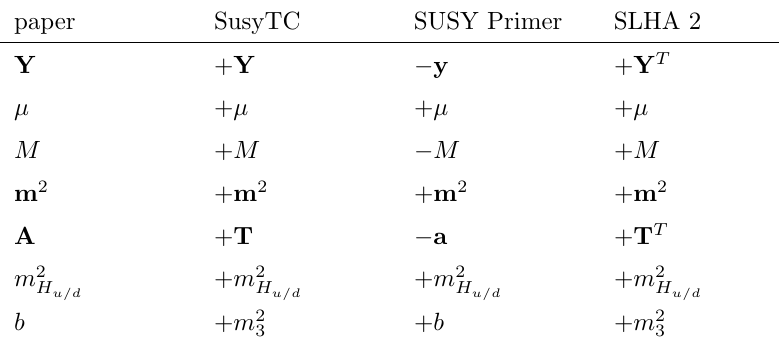
Table 1 . Comparison of the labels and conventions chosen in this paper for the quantities present in W MSSM in eq. (2.3) and L soft in eq. (2.4), with the conventions used by SusyTC, Martin’s Supersymmetry Primer and SLHA 2. All labels and family indices are neglected and right-handed neutrinos are not considered. The convention in this paper corresponds to the one in SusyTC. SusyTC and the SUSY Primer adhere to the RL convention for the Yukawa matrices and the trilinear couplings, SLHA 2 employs the LR